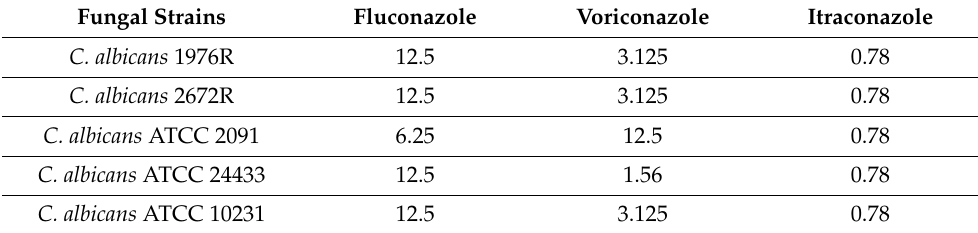
Table 1. Summary of the synergism between propranolol and azole antifungals. MIC ≥ 90% ( µ g/mL) of azoles in the presence of 100 µ g/mL